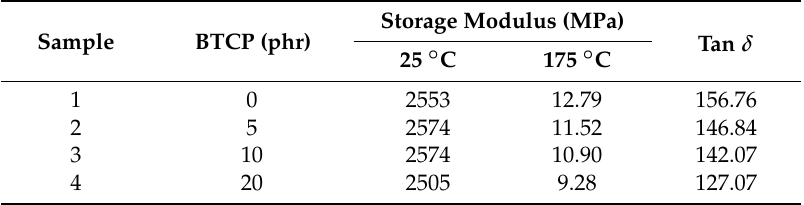
Table 5. DMA data of epoxy compositions.